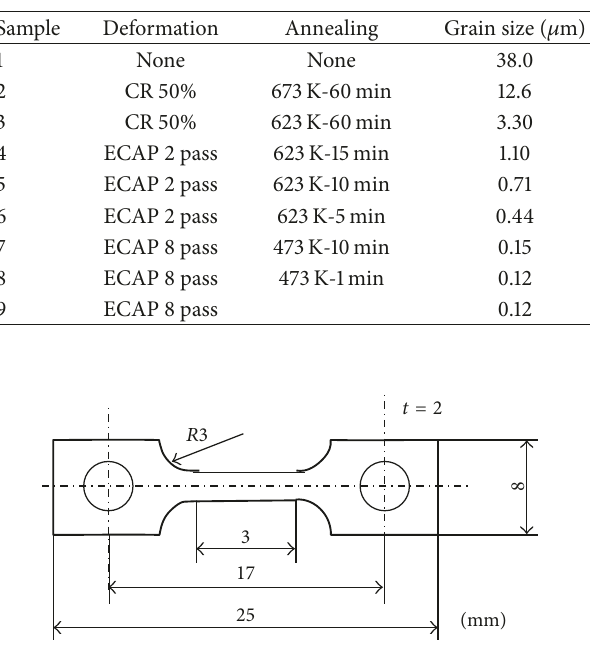
Figure 2: SCC specimen